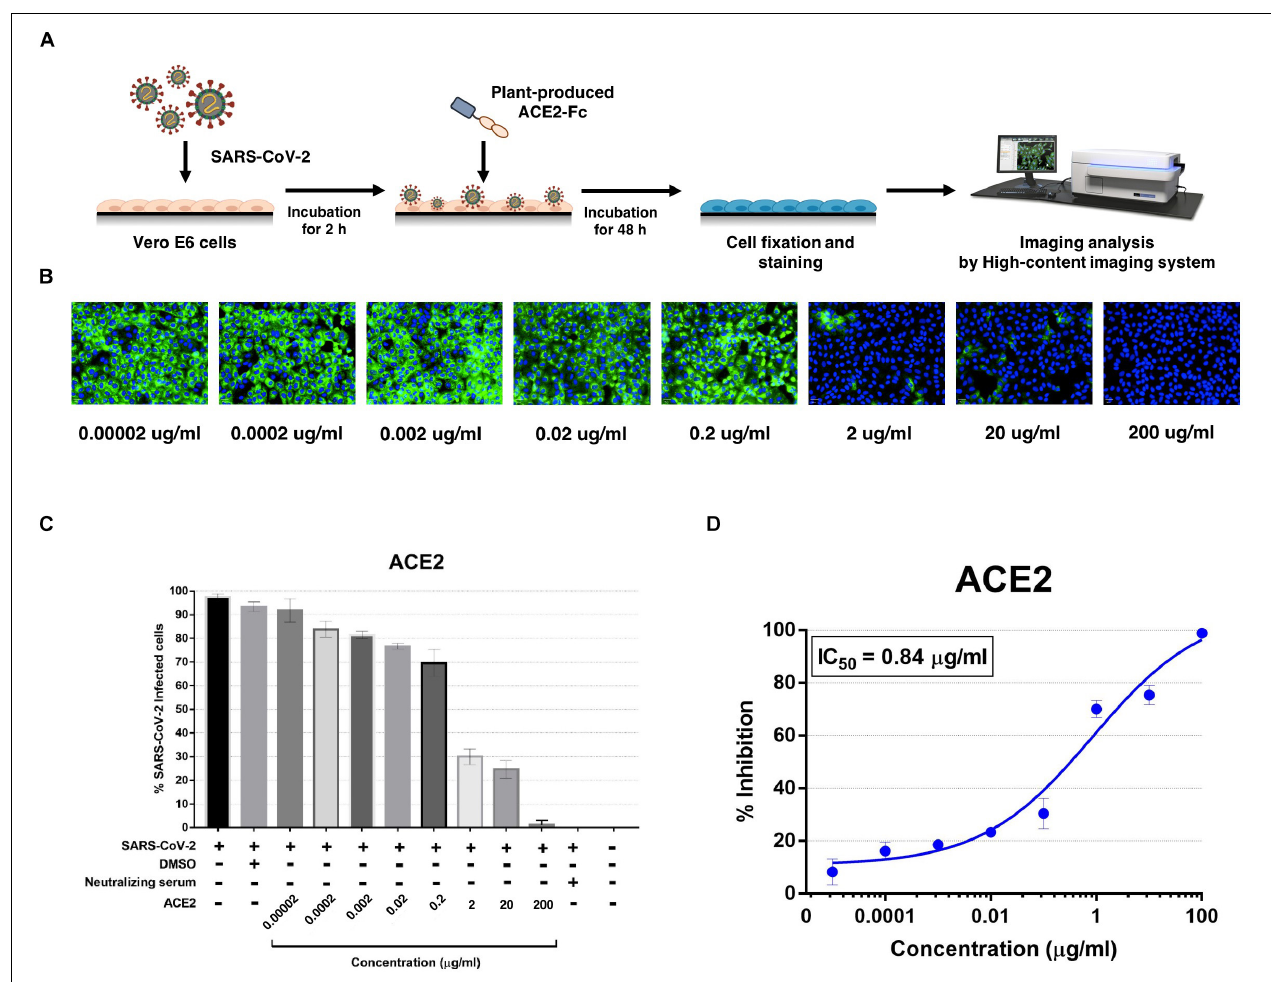
FIGURE 6 | Dose-dependent effect of plant-produced ACE2-Fc on SARS-CoV-2 inhibition and neutralization at the post-infection phase. Experimental design of plant-produced ACE2-Fc and SARS-CoV-2 mixture added to Vero E6 cells (at 25TCID 50 ) (A) . SARS-CoV-2 infection profiles in Vero E6 cells which were treated with eight concentrations of plant-produced ACE2-Fc (B) . Percentage of SARS-CoV-2 inhibition in Vero E6 cells, which were treated with eight concentrations of plant-produced ACE2-Fc starting with 200 µ g/ml (C) . Efficacy of SARS-CoV-2 inhibition in Vero E6 cells, which were treated by eight concentrations of plant-produced ACE2-Fc (D) . The data were showed as mean ± SD of triplicates in individual